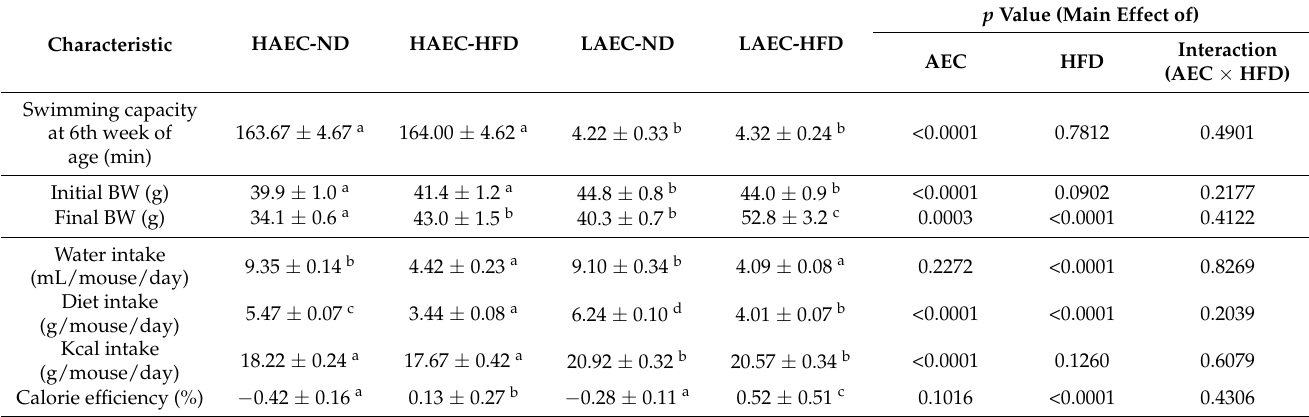
Table 1. Baseline exercise capacity, growth curve and dietary profiles during